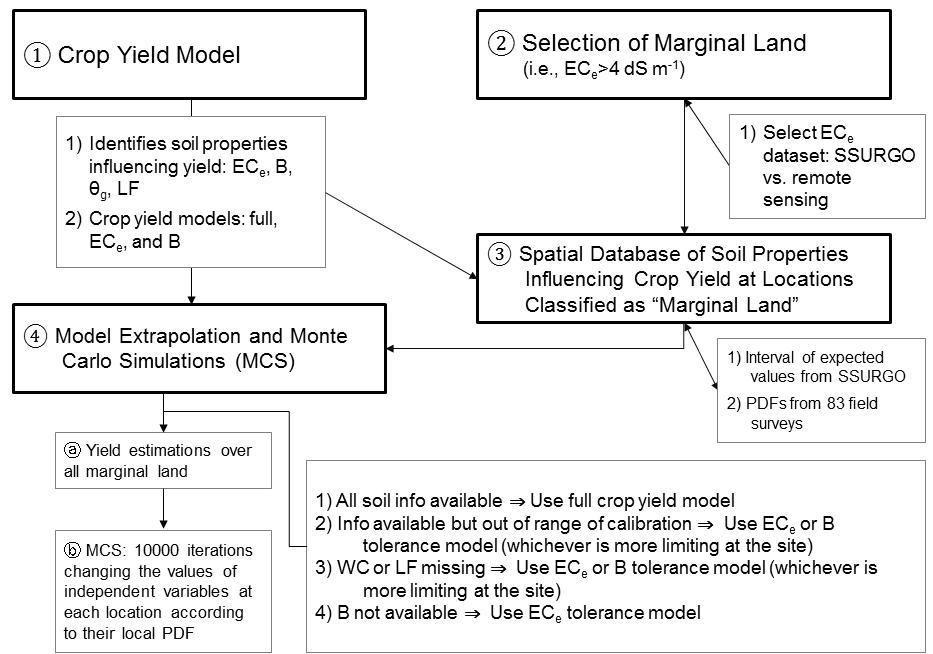
Figure 1. Flow chart of the feasibility evaluation of oilseed production on marginal soils in the San Joaquin Valley showing the four steps and flow of information.